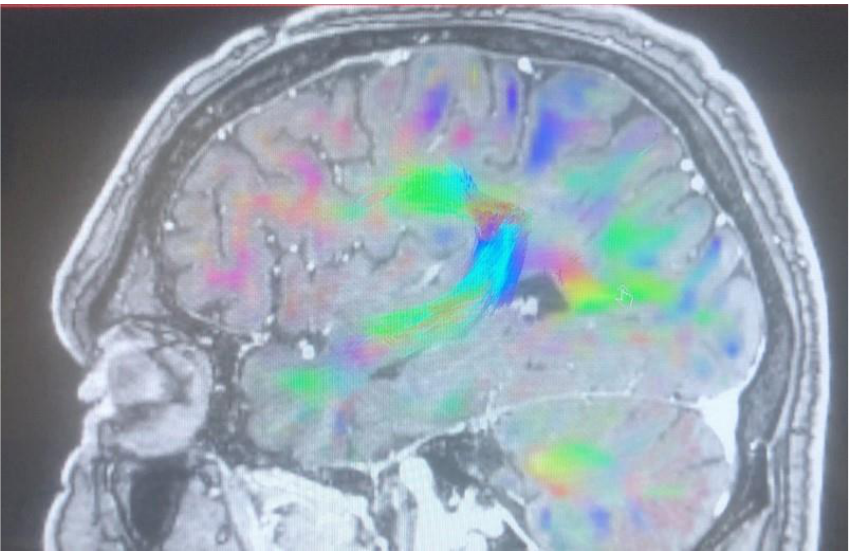
Figure 5. Arcuate fasciculus after cingulotomy.